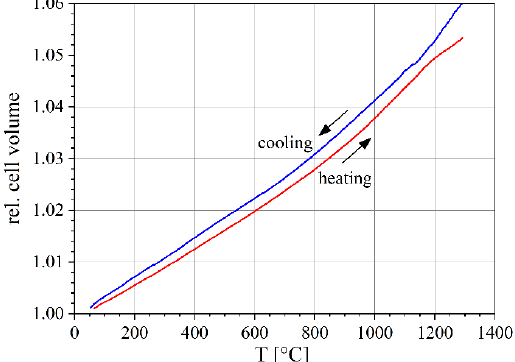
Figure 7. Ratio c / a of crystal axes for phases α 2 and γ as a function of temperature.